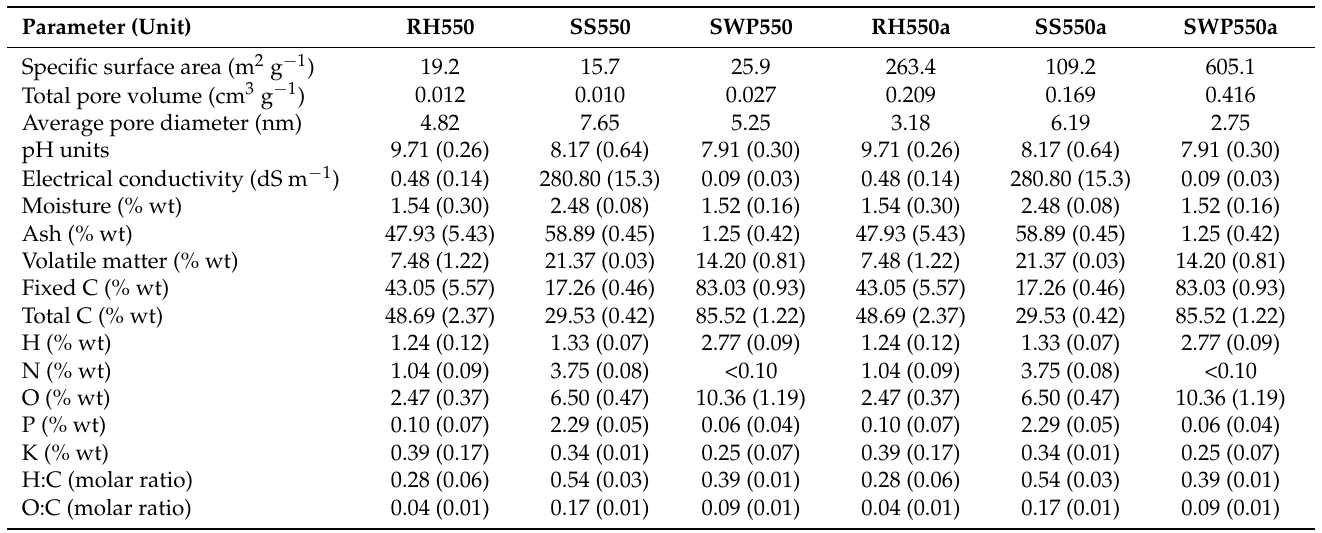
Table 2. Physic-chemical characteristics of the considered biochars (standard deviation in parentheses; ND: not